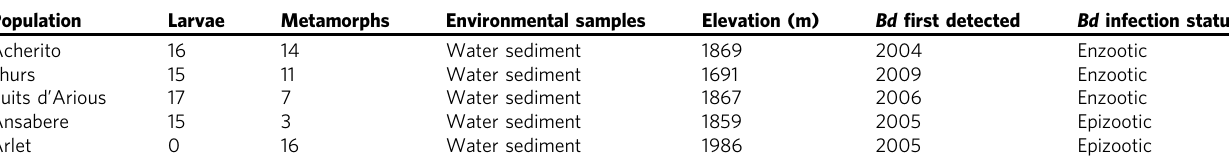
Table 1 Sample summary of each